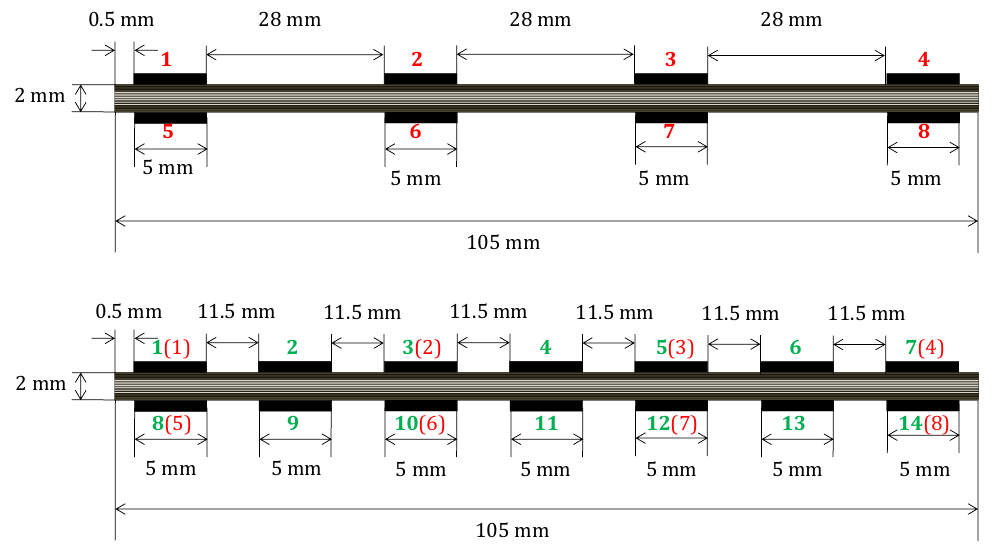
Figure 4. Laminate and electrode model used for the finite element analyses. Case of [ 0 4 /90 4 ] with eight electrodes ( top ) and 14 electrodes ( bottom ). Numbering for eight electrodes (red) and 16 electrodes (green) with its 8-electrode equivalence in